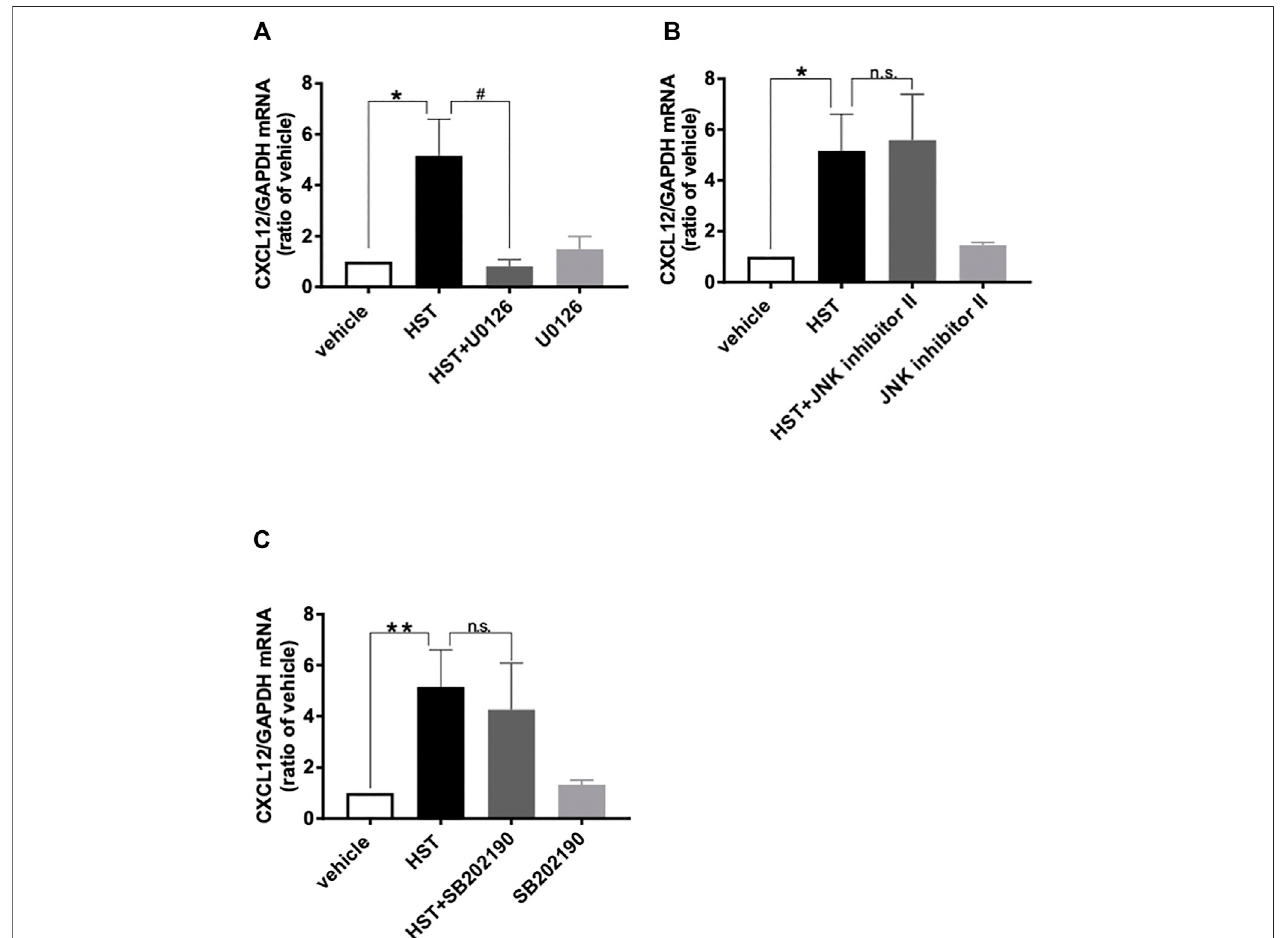
FIGURE 3 | Involvement of MAPKs in Hangeshashinto (HST)-induced expression of CXCL12 mRNA in human oral keratinocytes (HOKs). HOKs were scratched and co-treated with HST and inhibitors of (A) ERK (U0126; n (cid:2) 3 – 5), (B) JNK (JNK inhibitor II; n (cid:2) 3 – 5) or (C) p38 (SB202190; n (cid:2) 3 – 8) for 48 h. mRNA expression was determined by RT-qPCR. Data are expressed as the mean ± SEM (bars). *, ** indicates p < 0.05, p < 0.01 compared with vehicle, respectively; # indicates p < 0.05 compared with HST alone. Bonferroni ’ s comparison test following ANOVA (A – C) . n.s. indicates not signi fi cant (B,C) .